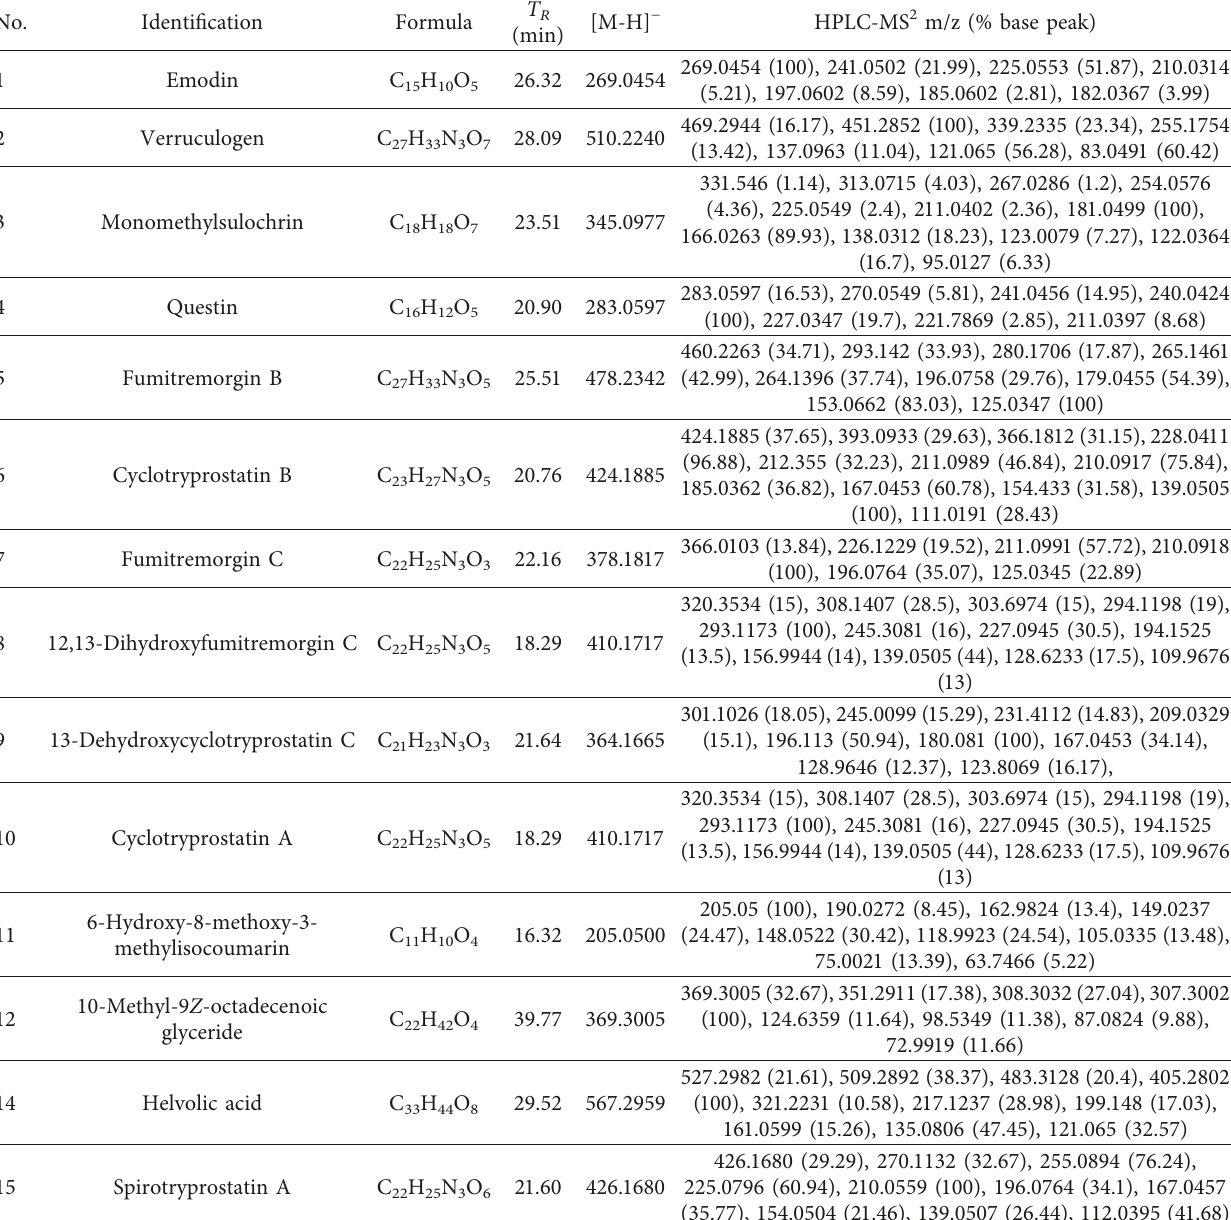
Table 2: Characterization of isolated compounds from